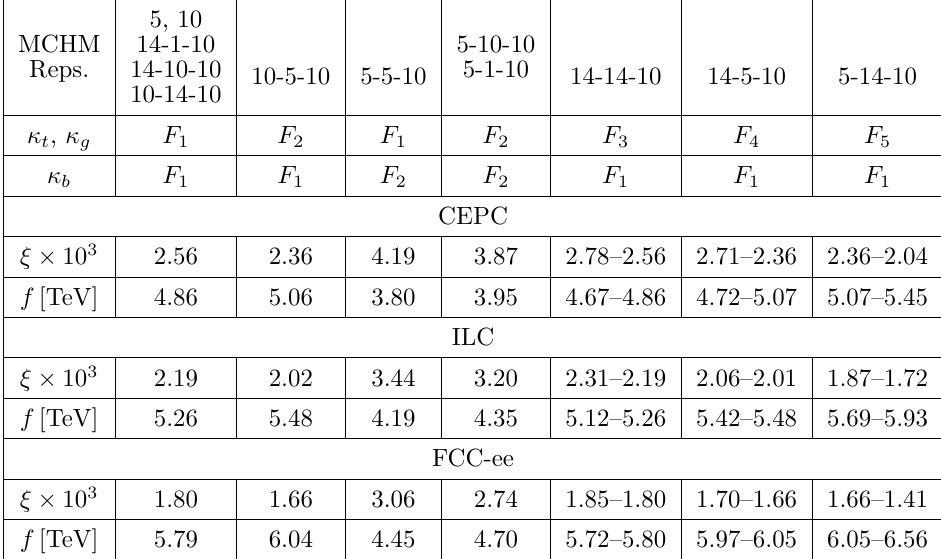
Table 5 . 95% C.L. bound on (cid:24) and global symmetry breaking scale parameter f for the